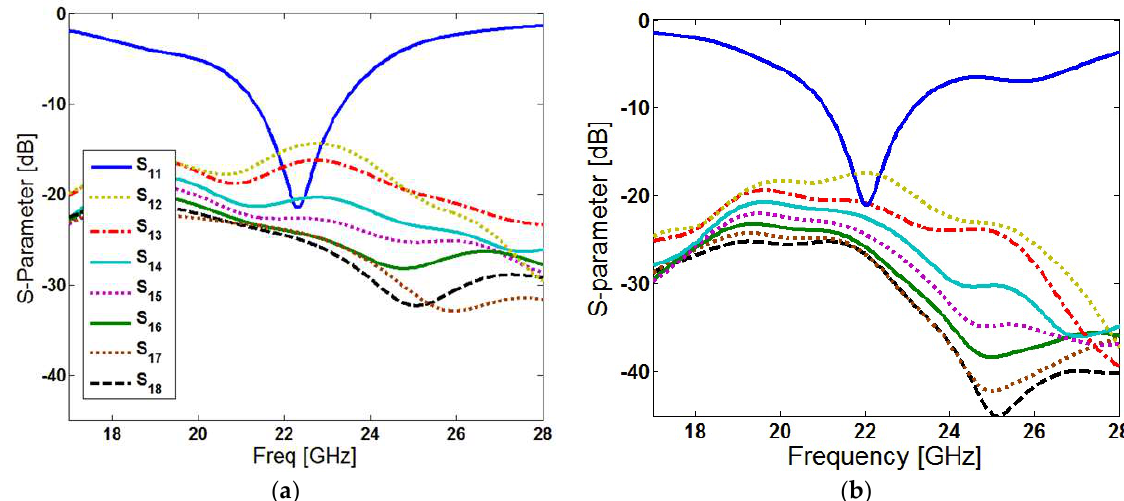
Figure 14. S parameters of the conventional array antennas, ( a ) slot antenna and ( b ) patch antenna.